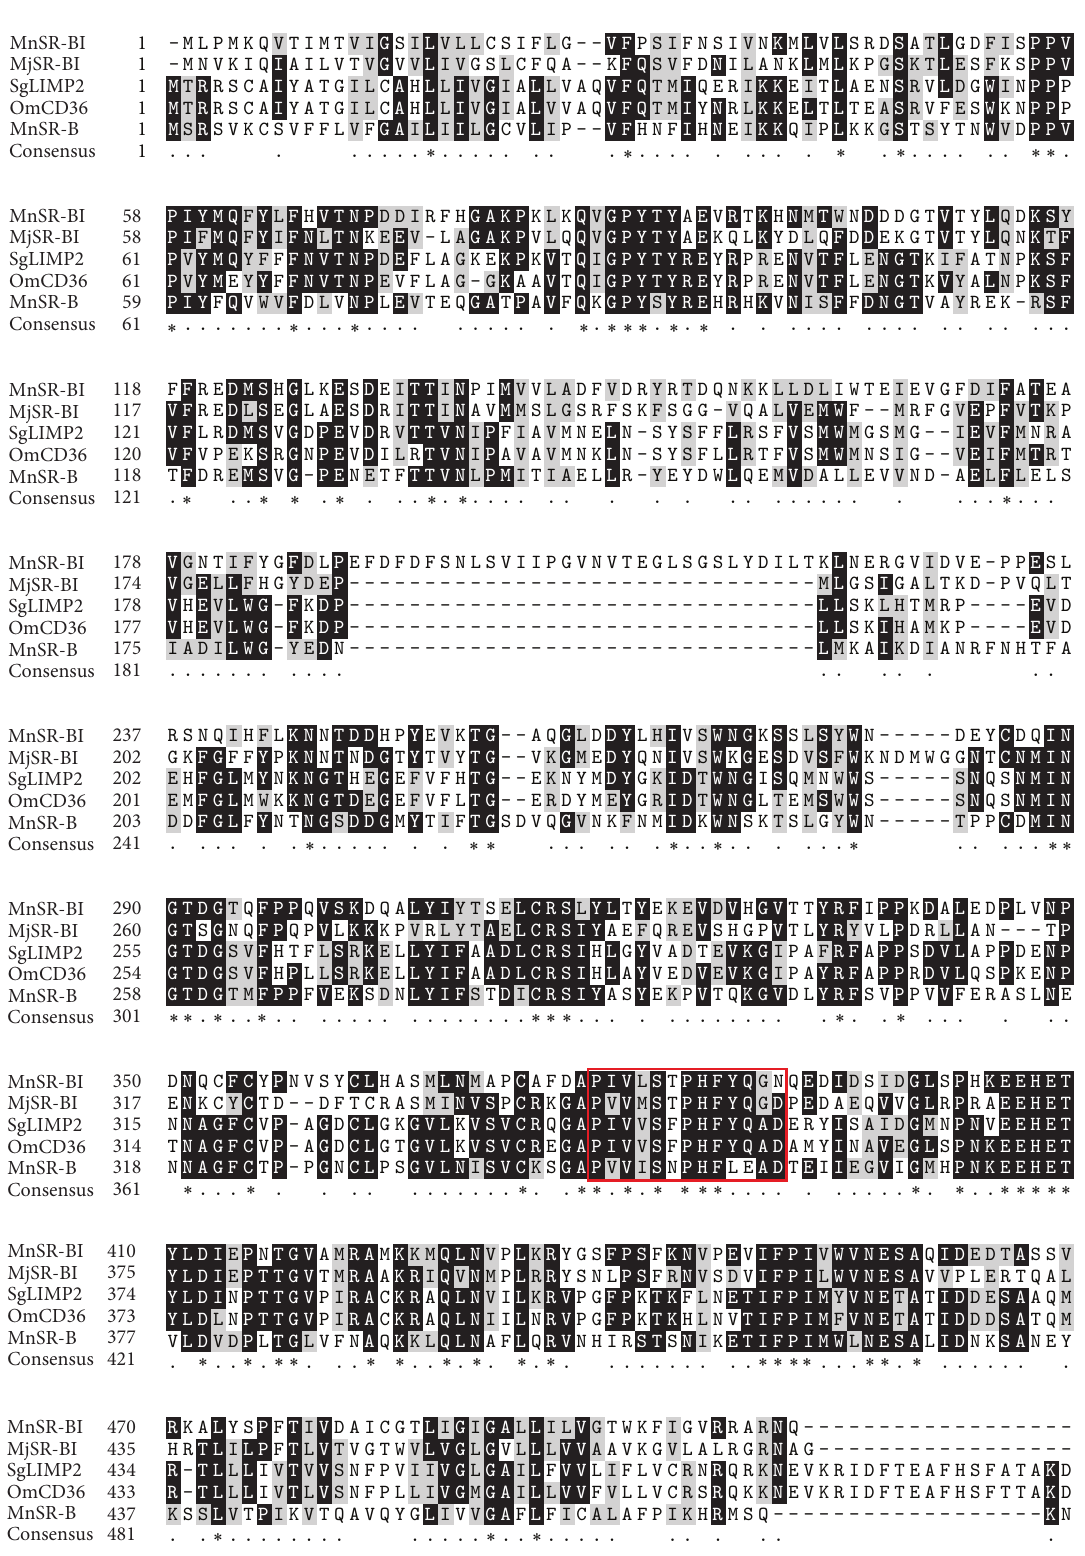
Figure 2: Multiple alignments of class B scavenger receptors. Species names are abbreviated on the left and represent Macrobrachium nipponense scavenger receptor class B, type I (MnSR-BI) [ALK82306]; Marsupenaeus japonicus scavenger receptor class B, type I (MjSR- BI) [AKO62849.1]; Sinocyclocheilus grahami lysosome membrane protein 2- (SgLIMP2-) like [XP 016108260.1]; Oncorhynchus mykiss CD36 antigen (OmCD36) [NP 001117983.1]; and Mimachlamys nobilis scavenger receptor class B- (MnSR-B-) like protein [AJM13625.1]. Identical residues are shaded black, while conserved groups are gray. A 13-amino acid motif present in members of the CD36 superfamily is highlighted by the red